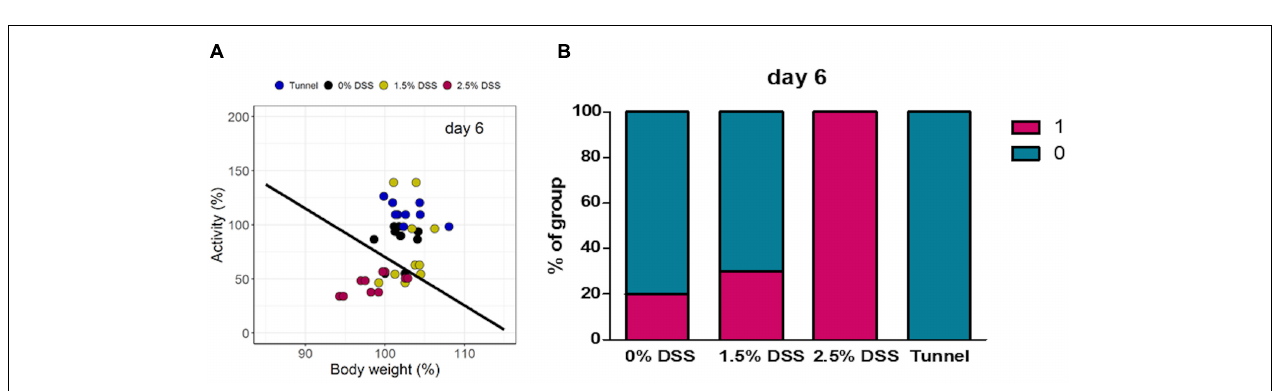
FIGURE 4 | Percentage change of initial activity of the experimental animals and the two handling groups. Percent of initial activity (A) of all three groups of the DSS-induced colitis model ( n = 5 cages each group) and (B) of the two handling groups ( n = 5 cages each group). Compared to bsl: one way RM ANOVA [tail: F ( 14 , 56 ) = 2.700, p = 0.0043; tunnel: F ( 14 , 56 ) = 3.703, p = 0.0002] + Dunnett’s post hoc test; *-***: 2.5% DSS, *: tail, #-## and #: tunnel. Comparison between the groups: DSS groups ($-$$): two-way RM ANOVA [time × group factor: F ( 28 , 168 ) = 2.354 p = 0.0004, group factor: F ( 2 , 12 ) = 0.7474 p = 0.4944]; handling groups: two-way RM ANOVA [time × group factor: F ( 14 , 112 ) = 1.039, p = 0.4212, group factor: F ( 1 , 8 ) = 0.002775, p = 0.9593].